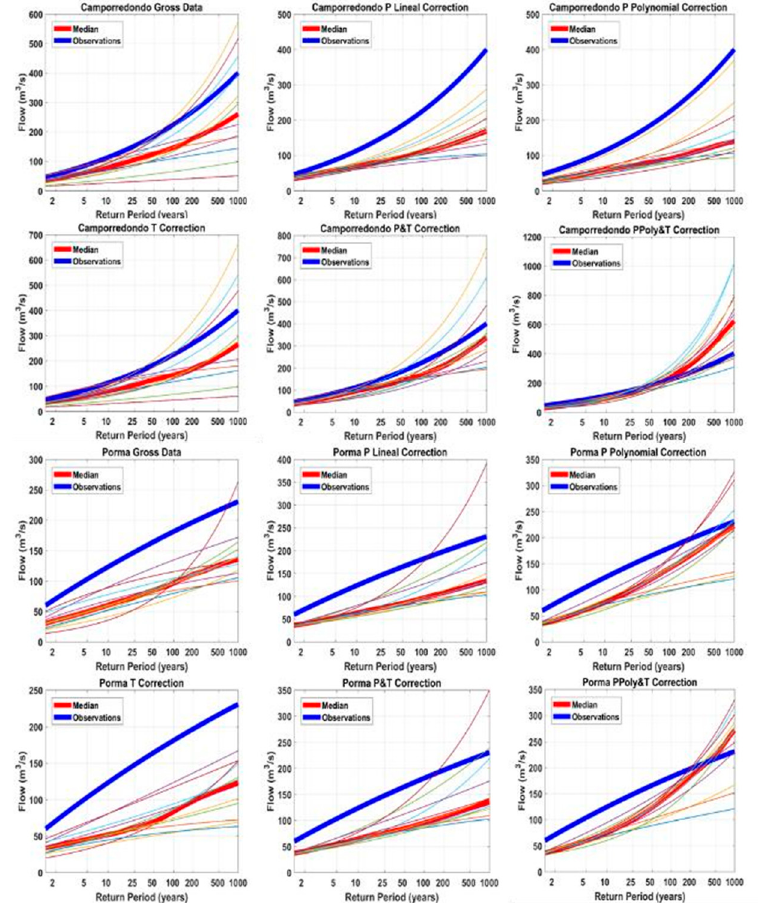
Figure 4. Comparison of flood frequency curves with observations and HBV simulations using a set of combinations of bias correction techniques in two catchments (Camporredondo and Porma). Blue lines are observations. Red lines represent the median of the 12 climate models